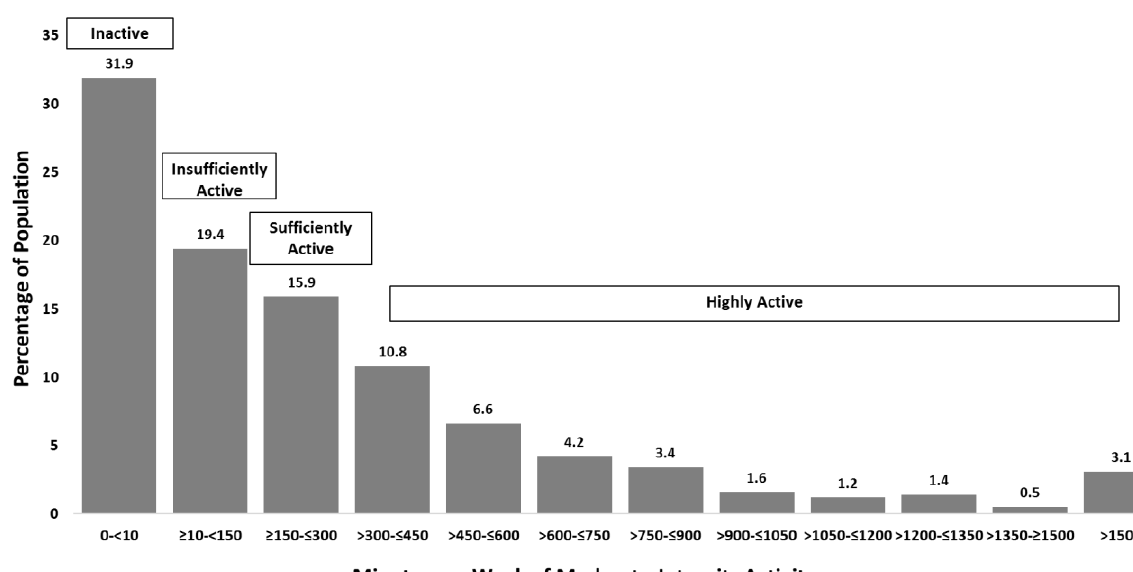
Figure C-3. Distribution of Self-Reported Volume of Moderate-to-Vigorous Physical Activity, 150 Minutes per Week Increments, U.S. Adults,